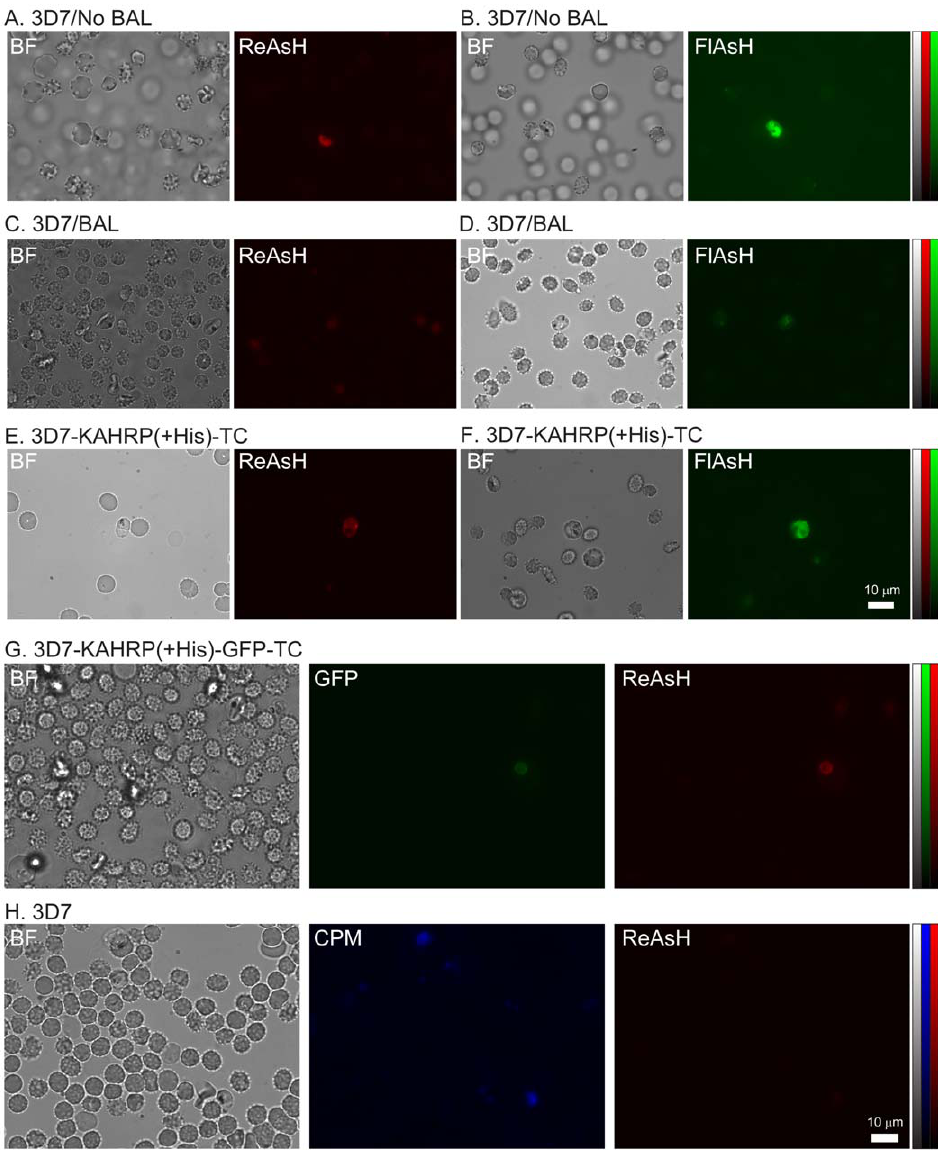
Figure 2. Fluorescence microscopy images of ReAsH and FlAsH labeled PEs. (A) Bright field (BF) and fluorescence images of non- transformed 3D7 PE labeled with ReAsH, not treated with BAL. (B) BF and fluorescence images of non- transformed 3D7 PE labeled with FlAsH, not treated with BAL. (C) BF and fluorescence images of 3D7 PE treated with BAL and labeled with ReAsH. (D) BF and fluorescence images of 3D7 PE treated with BAL and labeled with FlAsH. (E) BF and fluorescence images of 3D7-KAHRP( + His)-TC PE treated with BAL and labeled with ReAsH. (F) BF and fluorescence images of 3D7-KAHRP( + His)-TC PE treated with BAL and labeled with FlAsH. (G) BF and fluorescence images of 3D7-KAHRP( + His)- GFP-TC PE treated with BAL and labeled with ReAsH. (H) Images of non- transformed 3D7 PE exposed first to 200 m mol/L CPM and followed by labeling with 2.5 m mol/L ReAsH. Excitation and imaging of ReAsH, FlAsH and CPM fluorescence were performed with wavelengths and filter sets described in Materials and Methods. Scale bar represents 10 m